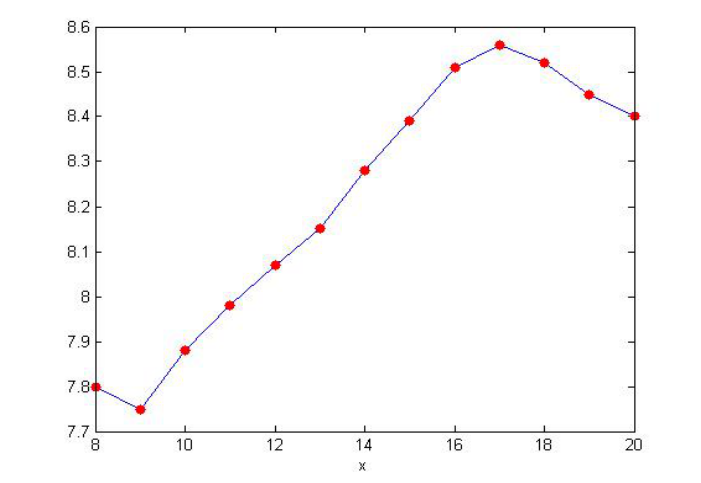
Figure 24. Curve of weekly pH changes monitored by the